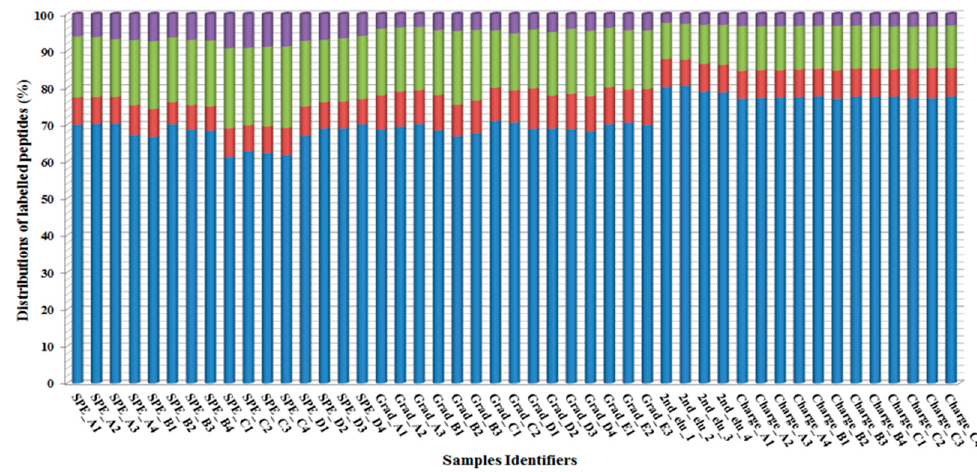
Figure 4. The distribution of cell surface labeled peptides per sample. The blue, red, green and purple color bars mark the percentage distributions of the labeled peptides from TMPs, non- TM_Subcellular_surface proteins, non-TM_GO_surface proteins and non-TM_non-surface proteins,